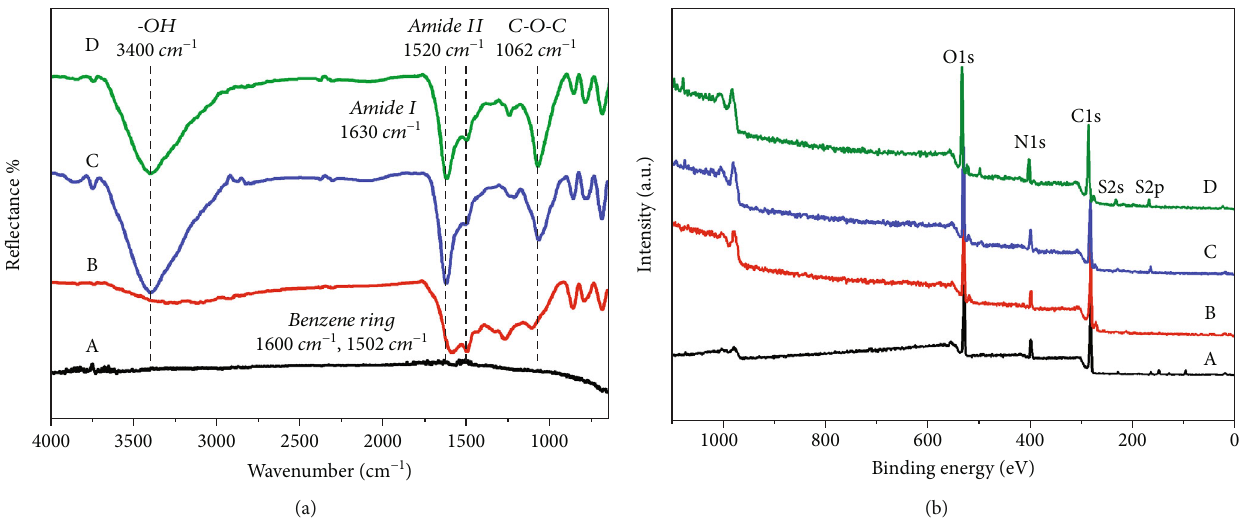
Figure 1: Surface chemical composition determined by (a) FTIR spectra and (b) XPS wide-scan spectra. (a) ~ (d) refer to 316L SS, SS-DA, SS- DA-NP, and SS-DA-NP@NGF, respectively.